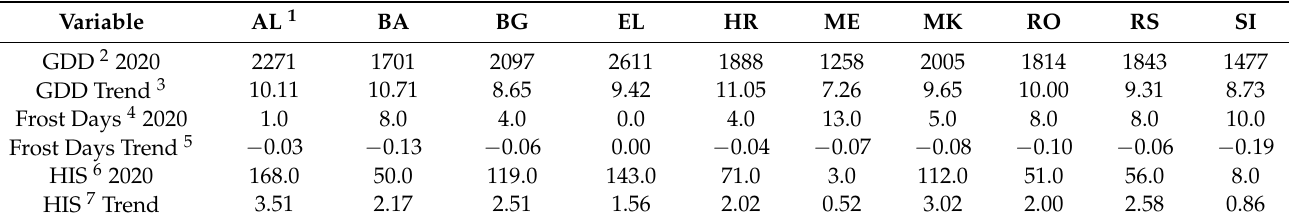
Table 2. The medians per variable and country for maize